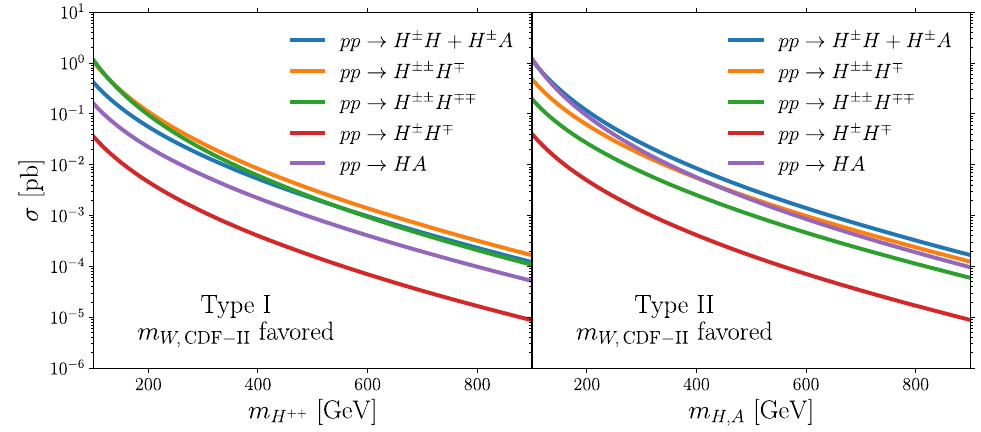
Fig. 6 NLO pair production cross sections for Type-I (left) and Type-II (right) as a function of m lightest at the 14 TeV run of the